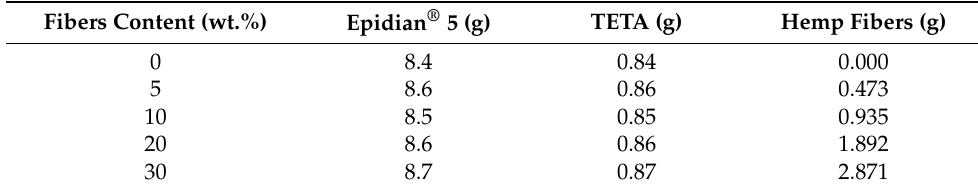
Table 1. Experimental parameters of the syntheses.